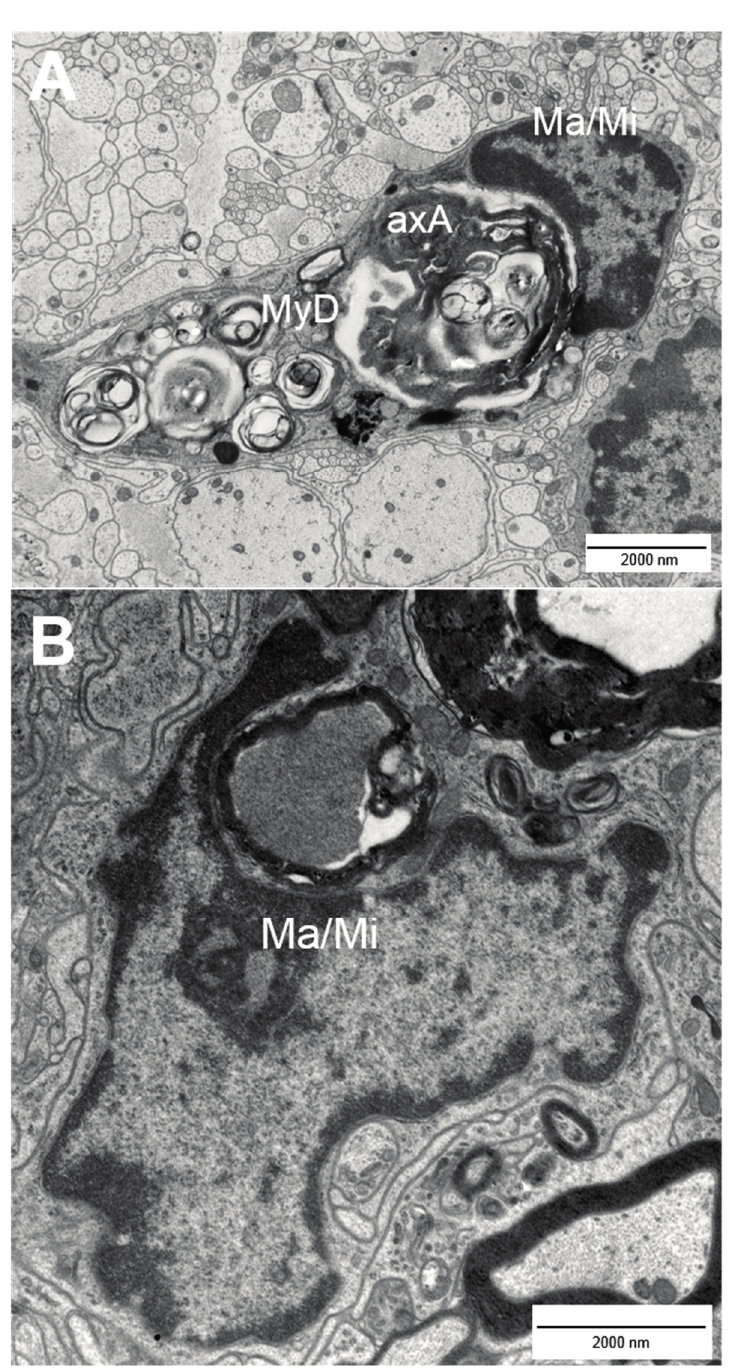
Figure 1. Incorporation of damaged nerve fibers by macrophages/microglia. Activated macrophages (Ma)/microglia (Mi) ( A , B ) phagocytose axolytic axons ( A , axA) and myelin debris ( A , MyD) within murine EAE spinal cord lesions. EAE = experimental autoimmune